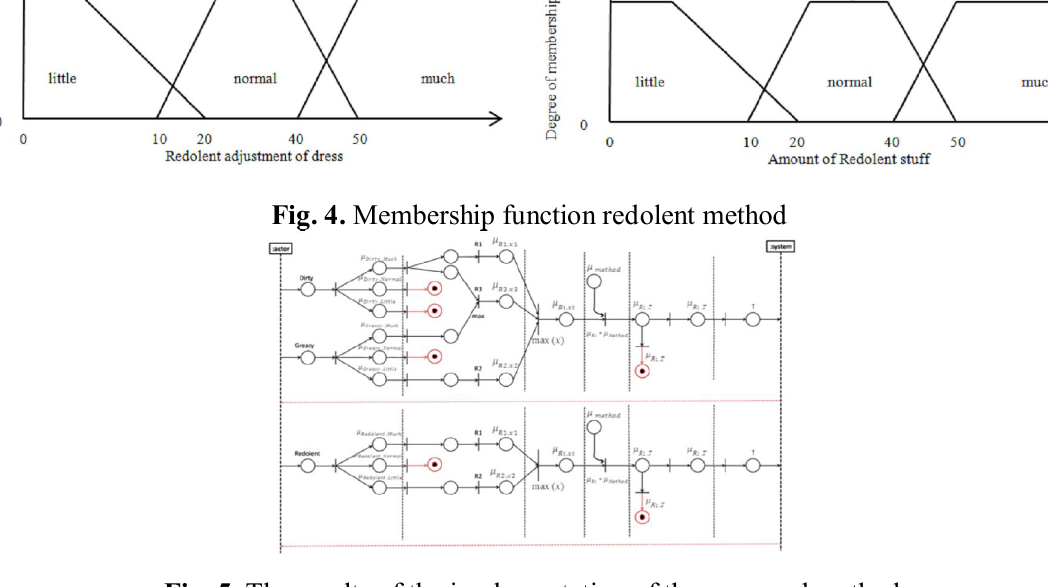
Fig. 5. The results of the implementation of the proposed